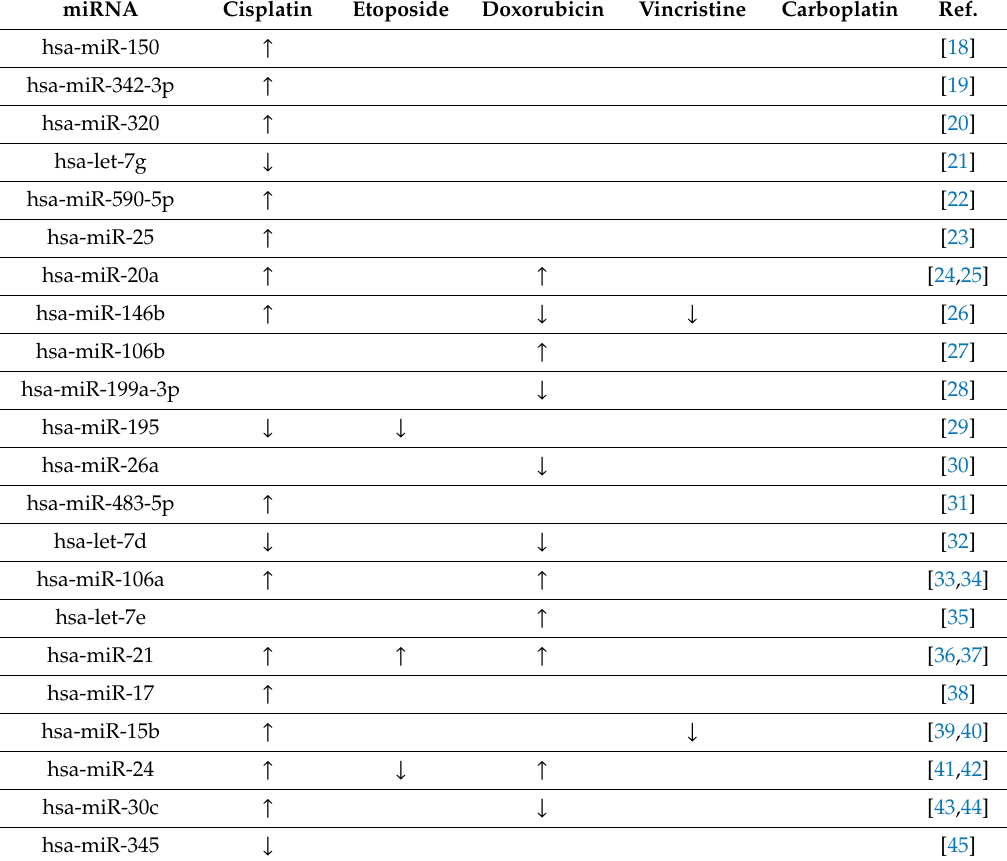
Table 3. Exo-miR associated to the response to chemotherapeutic